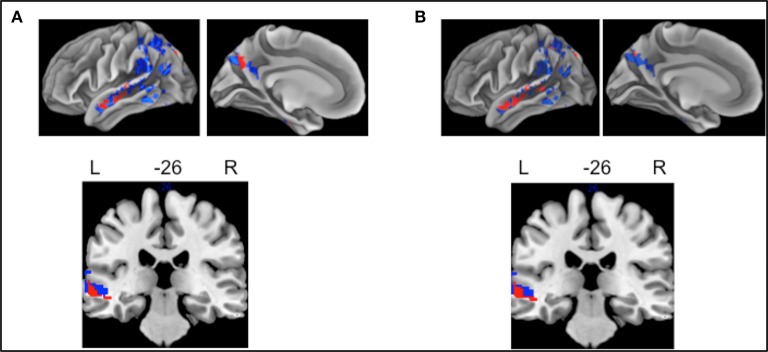
Whole Brain Atrophy and Regression in lvPPA. Pattern of atrophy of gray matter (GM), shown in blue (surface rendering and coronal slice), in lvPPA compared to controls. Atrophy was found only in the left hemisphere; these areas include middle temporal and parietal areas, significant at p < 0.005 (uncorrected with threshold-free cluster enhancement). (A) Decreased performance on BNT related to GM atrophy is shown in red. (B) Decreased performance on delayed free recall related to GM is shown in red. Left middle temporal gyrus regression for both BNT and delayed free recall was shown in the coronal slice.